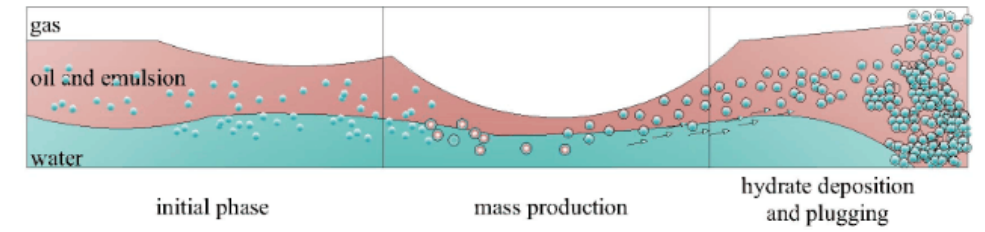
Figure 11. Schematic diagram of plugging mechanism at medium water cut